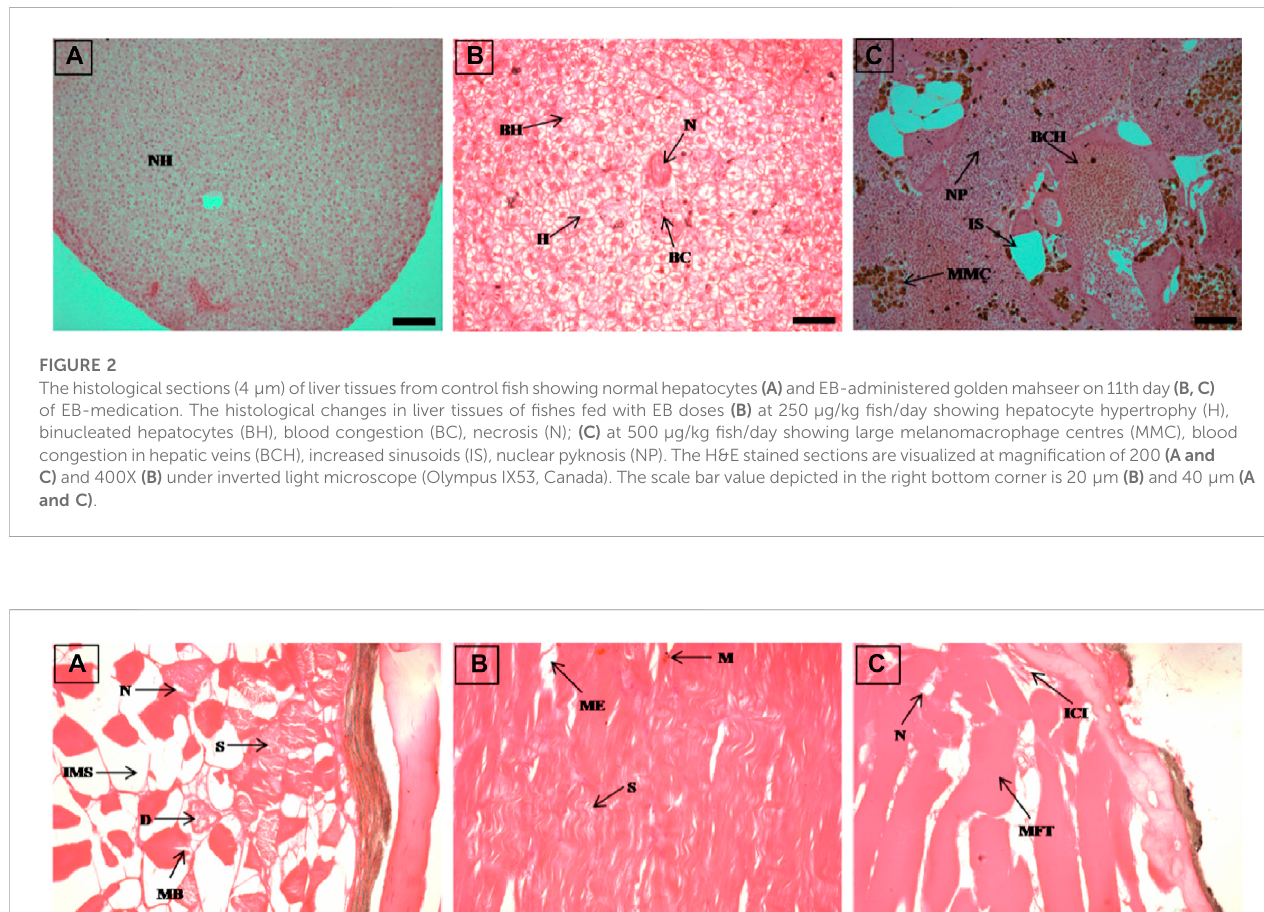
Figure 7 showed LC-MS/MS Chromatogram of Emamectin B 1a standard (A) and B 1b standard (B). The LC-MS/MS data indicated the presence of traces of EB in the muscle of the golden mahseer fed with graded levels of EB. The results illustrate the deposition of EB in the muscle tissues within the 21 days of medication period (Figures 8A,B). The increased concentration of EB in muscle tissues were observed in the fi sh treated with higher concentration. 30-day post-medication period, demonstrated gradual and signi fi cant decrease in the muscle residue of EB (Figures 8A,B) ( p < 0.05). At the end of 30 days medication period, the detected muscle Emamectin B 1a concentrations in 1×, 2×, 5×, and 10× treatment groups were 1.1 ±